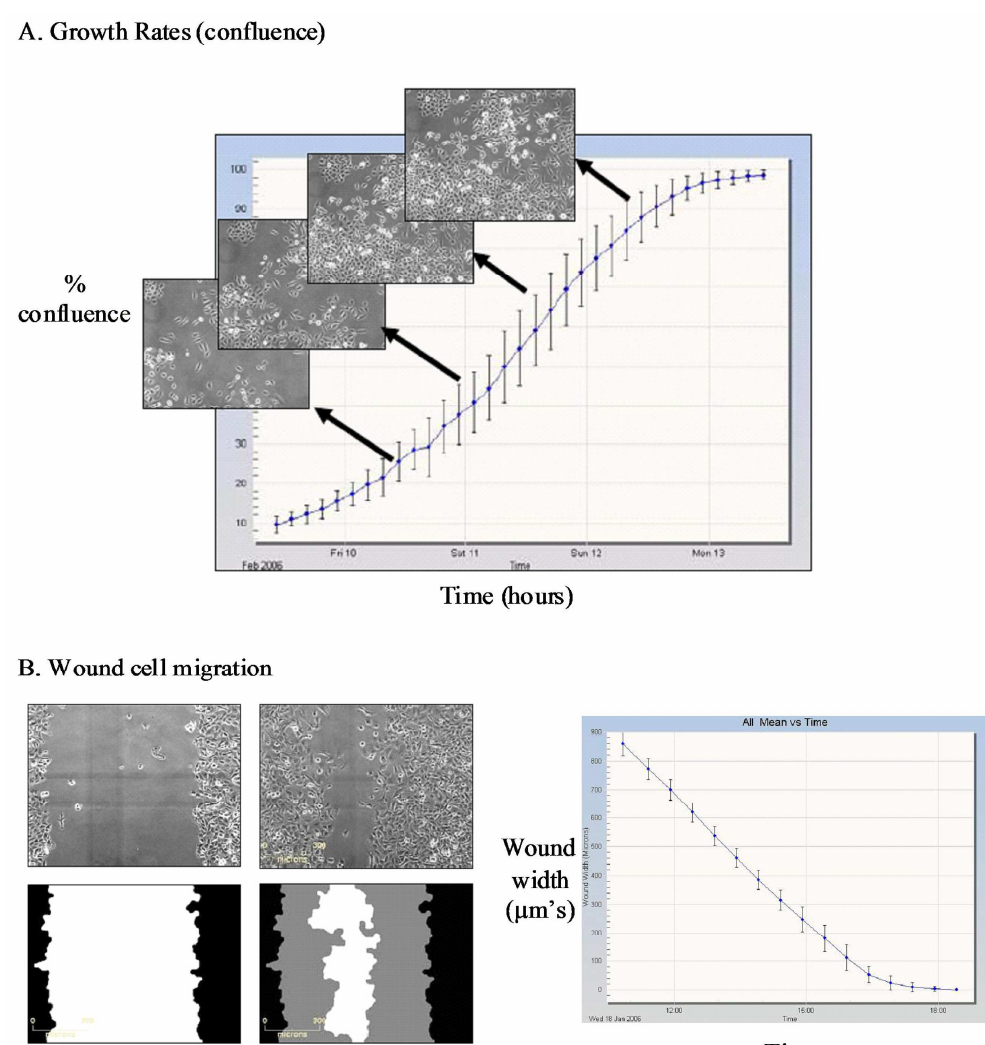
Figure 1. IncuCyte TM kinetic imaging platform and applications. Kinetic monitoring and quantification of ( A ) cell confluence, ( B ) cell migration following wounding of a monolayer of HT1080 fibrosarcoma cells. Data represents wound width ( m m) at sequential time points quantified using the IncuCyte migration application module. ( C ) Angiogenesis in a human primary co-culture model of endothelial (HUVEC) and fibroblast cells where HUVECs have been labeled with GFP. Data represents cells treated in co-culture with VEGFR2 inhibitor (0.1 m M) or vehicle control for 10 days. Tubule area quantified using the IncuCyte angiogenesis algorithm. ( D ) Caspase-mediated apoptosis in a human micovascular endothelial cell line (HMEC-1) treated with Staurosporine (0.3 µM) and cultured in the presence of NucView TM caspase substrate. Caspase positive cells quantified using the IncuCyte object counting algorithm. n = 3 (error bars are standard